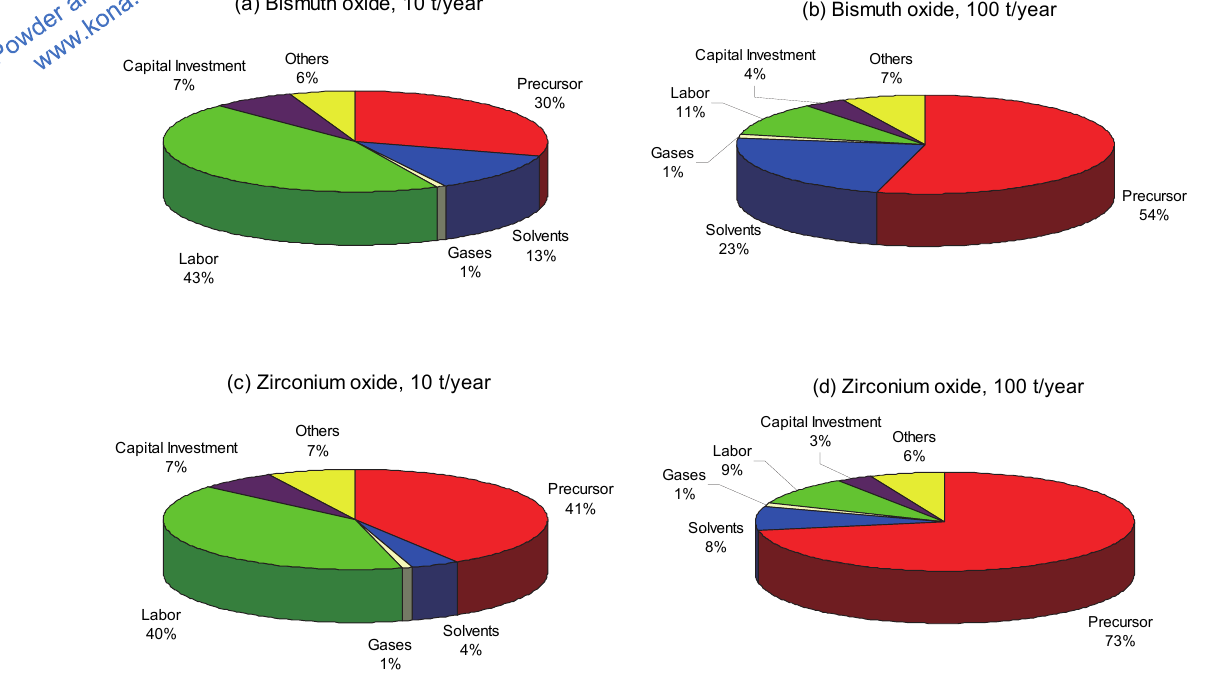
Fig. 9 Estimated production cost breakdown for (a, b) bismuth and (c, d) zirconium oxide nanoparticles produced with FSP pilot plants operating at 1.25 kg/h (10t/year) and 12.5 kg/h (100 t/year). At the higher production rate, the raw materials (precursor and solvents) account for approximately 80% of the production